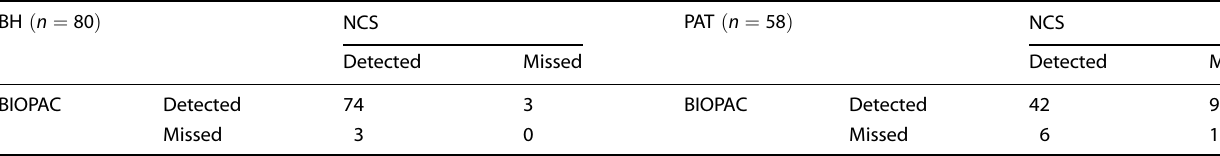
Table 2. Detection of breath-hold (BH) and paradoxical abdomen-thorax (PAT) motion.